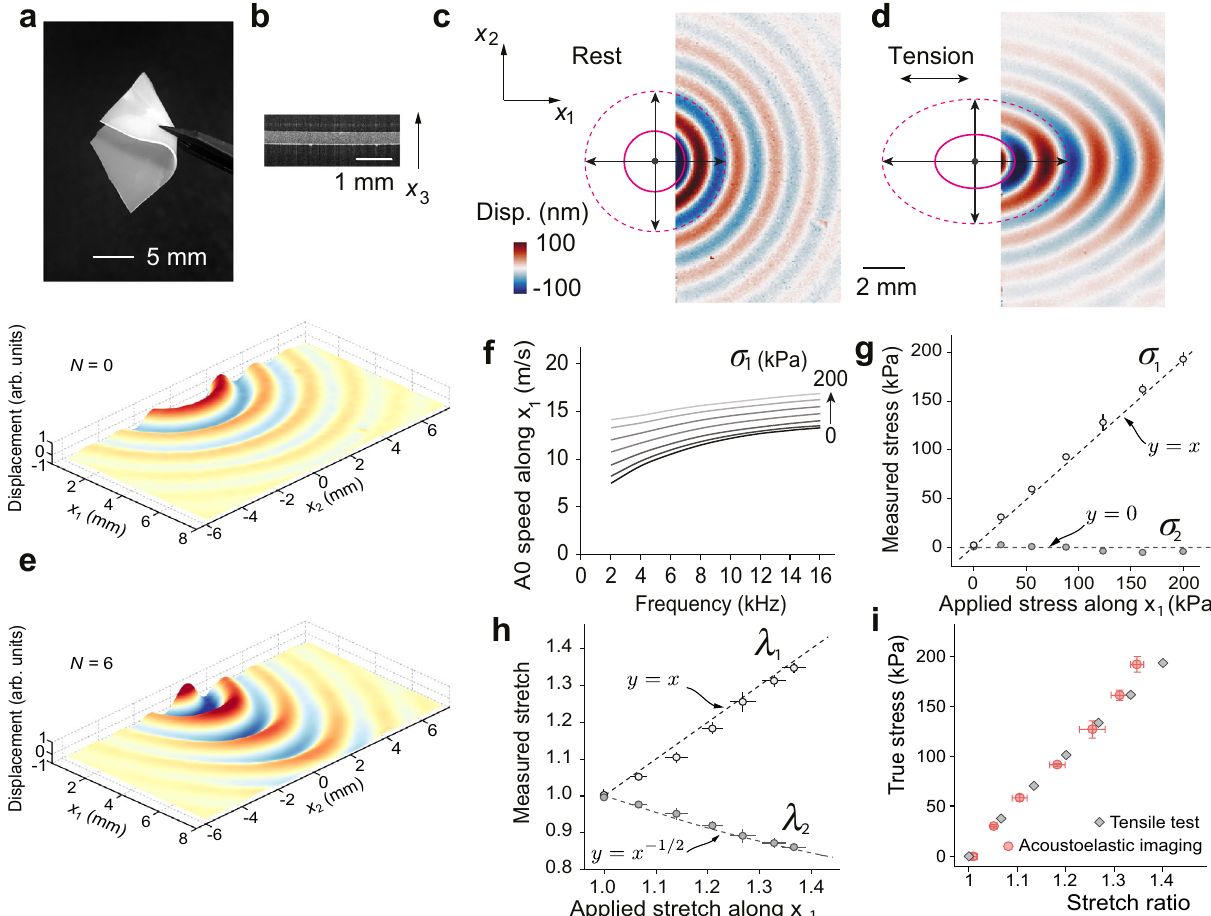
Fig. 1 Imaging and analysing elastic waves in a stretched rubber membrane. a Photograph of our rubber sheet. b Optical Coherence Tomography (OCT) cross-sectional image. c , d Wave pro fi les measured by OCT when the fi lm is c stress-free and d subject to uniaxial stress σ 1 ≃ 200 kPa, see Supplementary Movies 1 and 2. The wavefronts become elliptical when stretched. e Corresponding 3D wavefronts, obtained by measuring the vertical displacement from the phase change in the interference signal of the OCT; N indicates the number of weights (each with mass 20 g). f Dispersion relations of the A0 mode obtained at different levels of stress. Each curve is an average over six measurements (for clarity the error bar is not shown here but can be found in Supplementary Fig. 11). g Comparison between measured and applied stress values ( σ 1 , σ 2 : stress components along, and perpendicular to, the direction of tension, respectively). For reference, the dashed lines show where the measured stresses are equal to the applied stresses. h Comparison between the measured and applied stretch values ( λ 1 , λ 2 : stretch ratios along, and perpendicular to, the direction of tension, respectively). Dashed lines, expected 1 and -1/2 power laws of the stretches for reference. i Stress-strain curve from the measured data compared to that measured by a standard tensile test. Error bars are the standard deviations from